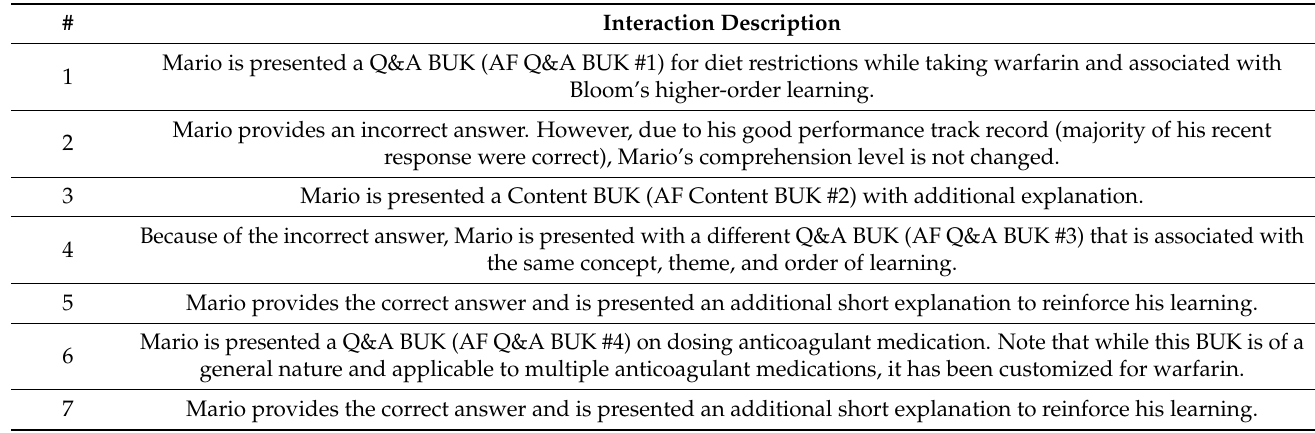
Table 2. Interactions between Mario and the framework in the AF use case (high comprehension level, preferred learning style: V and R). For the identifiers of Q&A and Content BUKs, refer to Figure 6a. Interaction